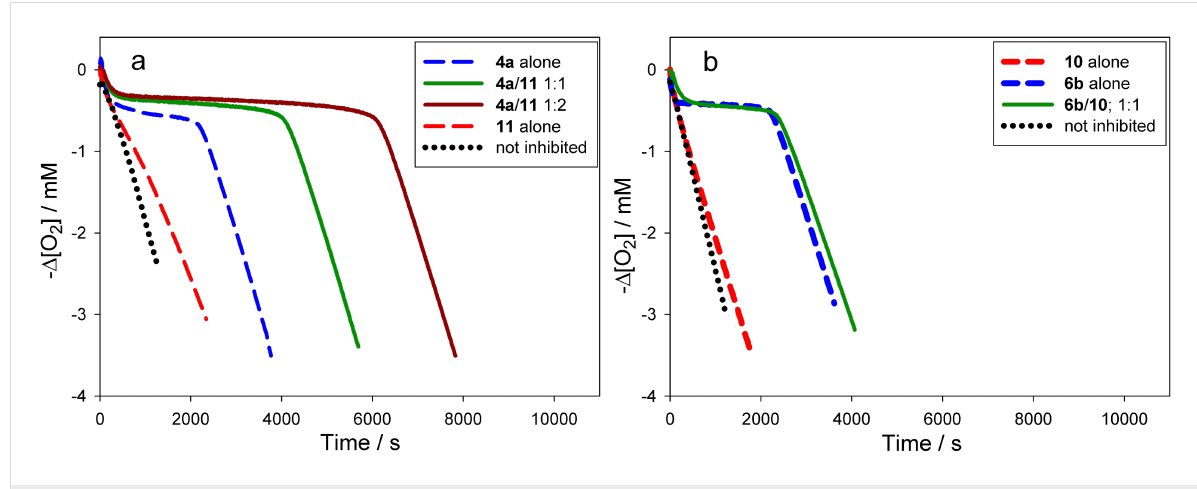
Figure 3: Oxygen-uptake plots recorded during the AIBN initiated autoxidation of styrene in chlorobenzene (50% v/v) at 303 K in the absence or pres- ence of: (a) 4a (6.2 × 10 − 6 M), 11 (6.2 × 10 − 6 M) or a mixture of 4a (6.2 × 10 − 6 M) with either one or two equivalents of 11 ; (b) 6b (6.2 × 10 − 6 M), 10